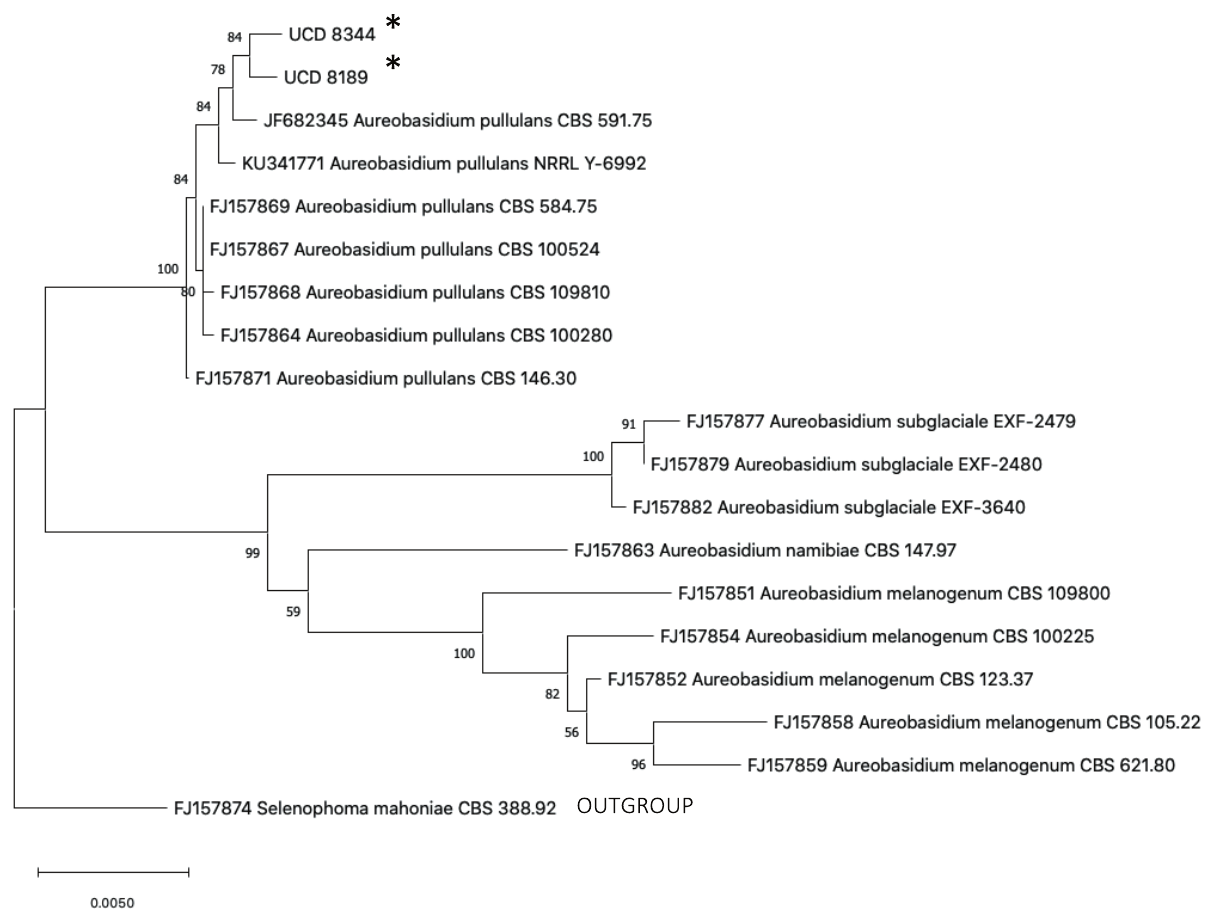
Figure 6. Maximum parsimony phylogenetic tree for isolates UCD 8344 and UCD 8189 based on a multigene data set of internal tran- scribed spacer rDNA (ITS) and b1-tubulin. Bootstrap support for the maximum-likelihood analysis is given at each node (1000 replicates). * indicates isolates evaluated in the present study. Selenopoma mahoniae FJ150872 was used as an